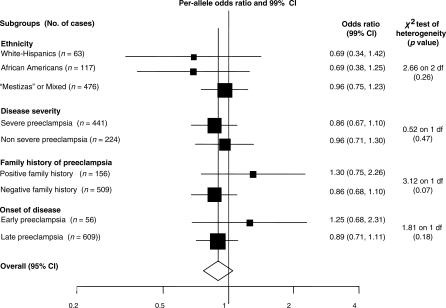
Risk Association of ACE-I/D Variant with Preeclampsia in Selected Subgroups within the Current Study